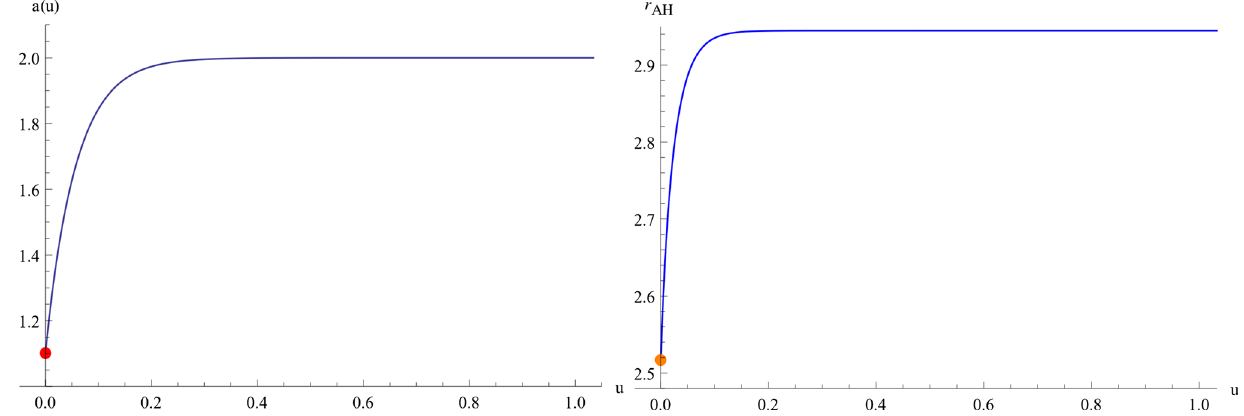
Fig. 1 Left panel: The evolution of the scalar function a ( u ) for the four dimensional solution with k 0 = 1 and γ 2 > 0. We have set √ √ γ = 1 ,α = 1 / 3 , c = 5 , Q = 4 so that q − = 1 , q + = 2. 2 Right panel: The evolution of the apparent horizon. We further set